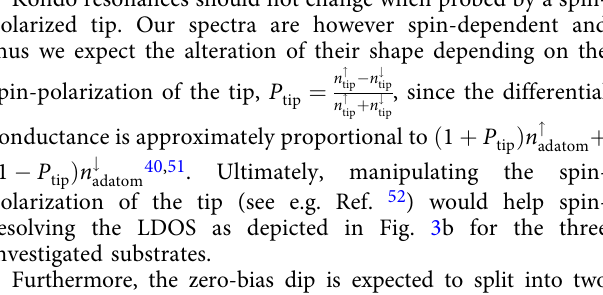
perfect agreement with the ones obtained from experimental data.